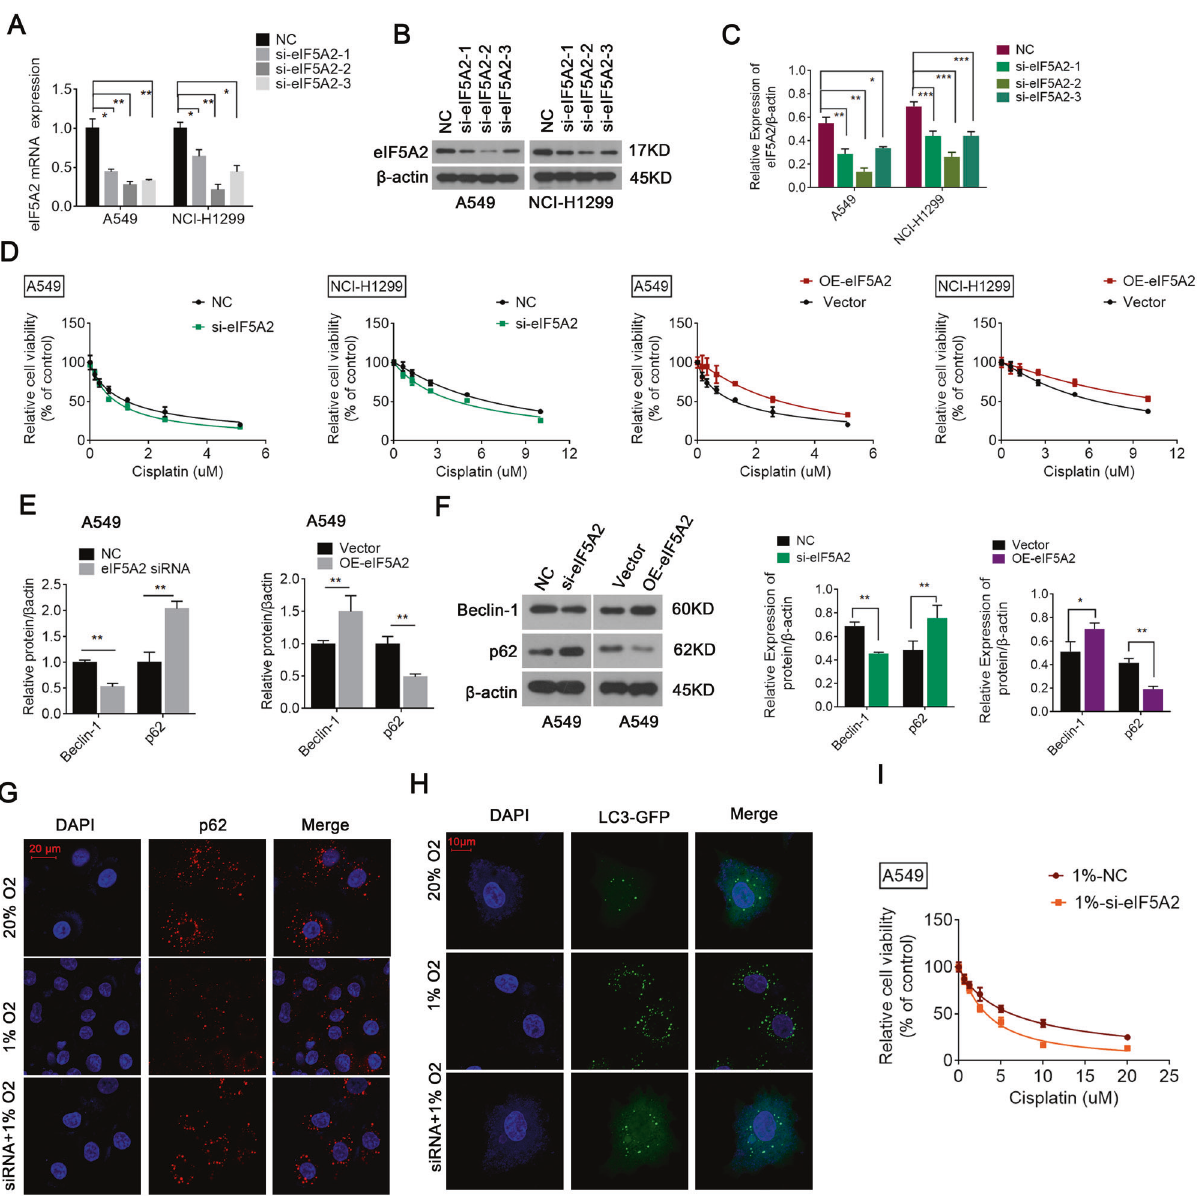
Fig. 4 Silencing eIF5A2 effectively decreases the autophagy and cisplatin resistance in NSCLC cells. A – C qRT-PCR A and western blotting B , C results con fi rming successful transfection. D The results of CCK8 assays suggesting that compared with the negative control, the cell viability of A549 and NCI-H1299 treated with cisplatin decreased after knockdown of eIF5A2, and increased after overexpression of eIF5A2. E , F qRT-PCR E and western blotting ( F ) results proving that compared with the negative control, Beclin-1 expression decreased and p62 expression increased after EIF5A2 silencing ( E ), which could be reversed by overexpressing eIF5A2 ( F ). G , H Staining for p62 (green) and DAPI nuclear staining (blue) in A549 cells, con fi rming the reduced expression of p62 and the enhanced expression of LC3 under hypoxic conditions, and both p62 and LC3 were located in the cytoplasm. However, after silencing eIF5A2, the expression levels of p62 ( G ) and LC3 ( H ) did not decrease, even under hypoxic conditions. I The results of a CCK8 assay suggesting that compared with NC-transfected A549 cells, the